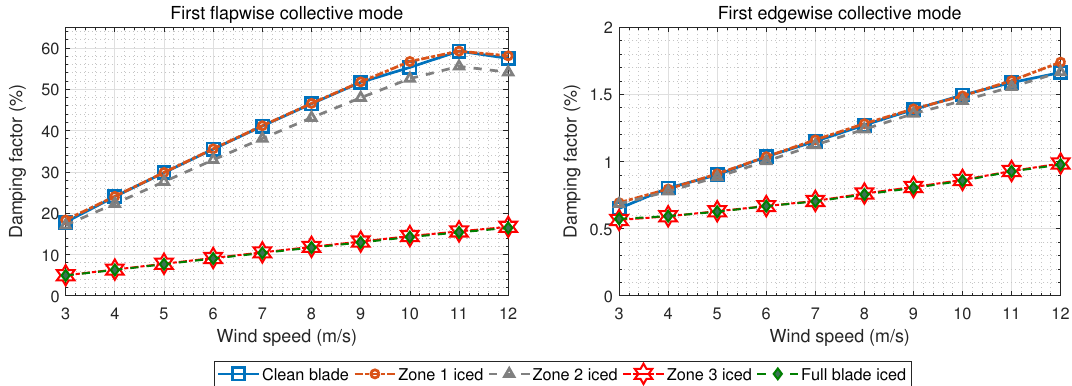
Figure 17. Influence of icing in different locations of the blade on the damping factors of first collective flapwise and edgewise vibration modes. The scale for the damping factor graphs is